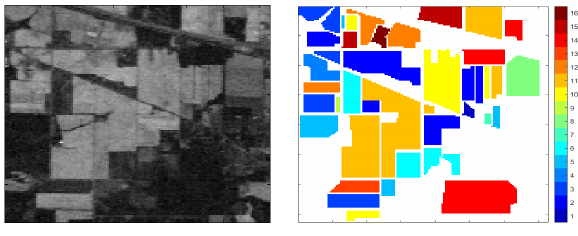
Figure 1. Hyperspectral Indian pines image and its ground-truth